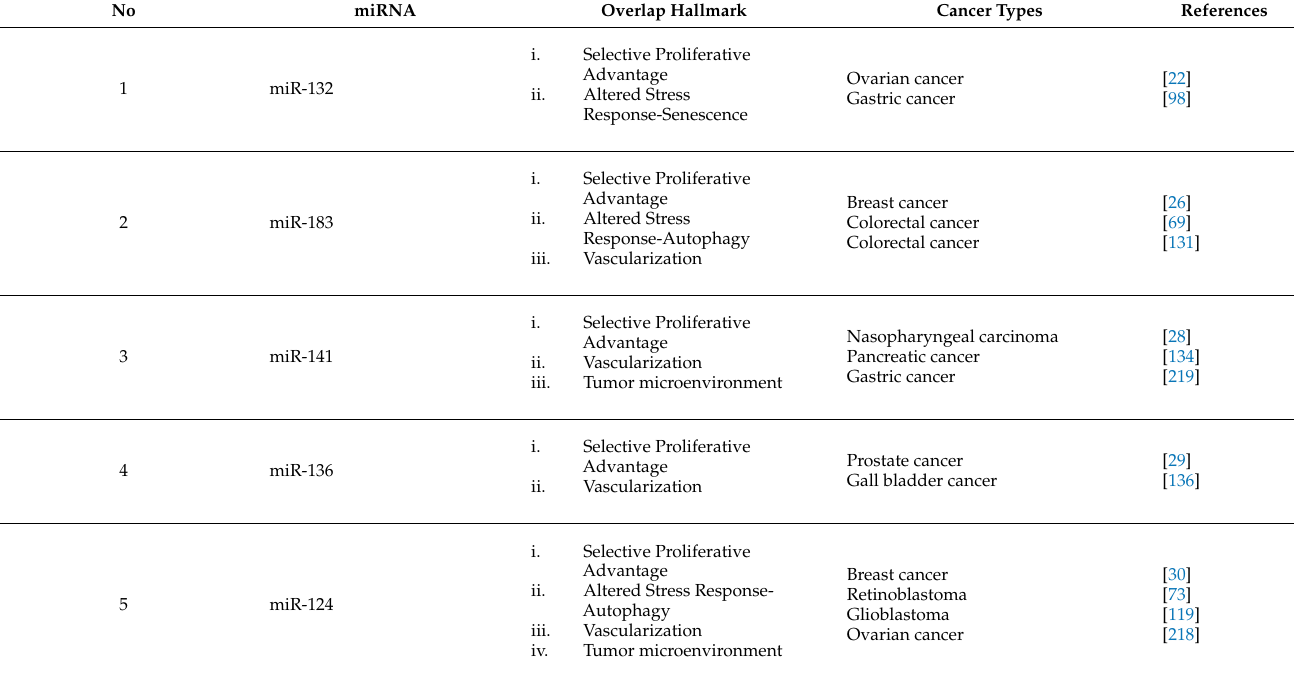
Table 12. The miRNA exhibiting an overlap